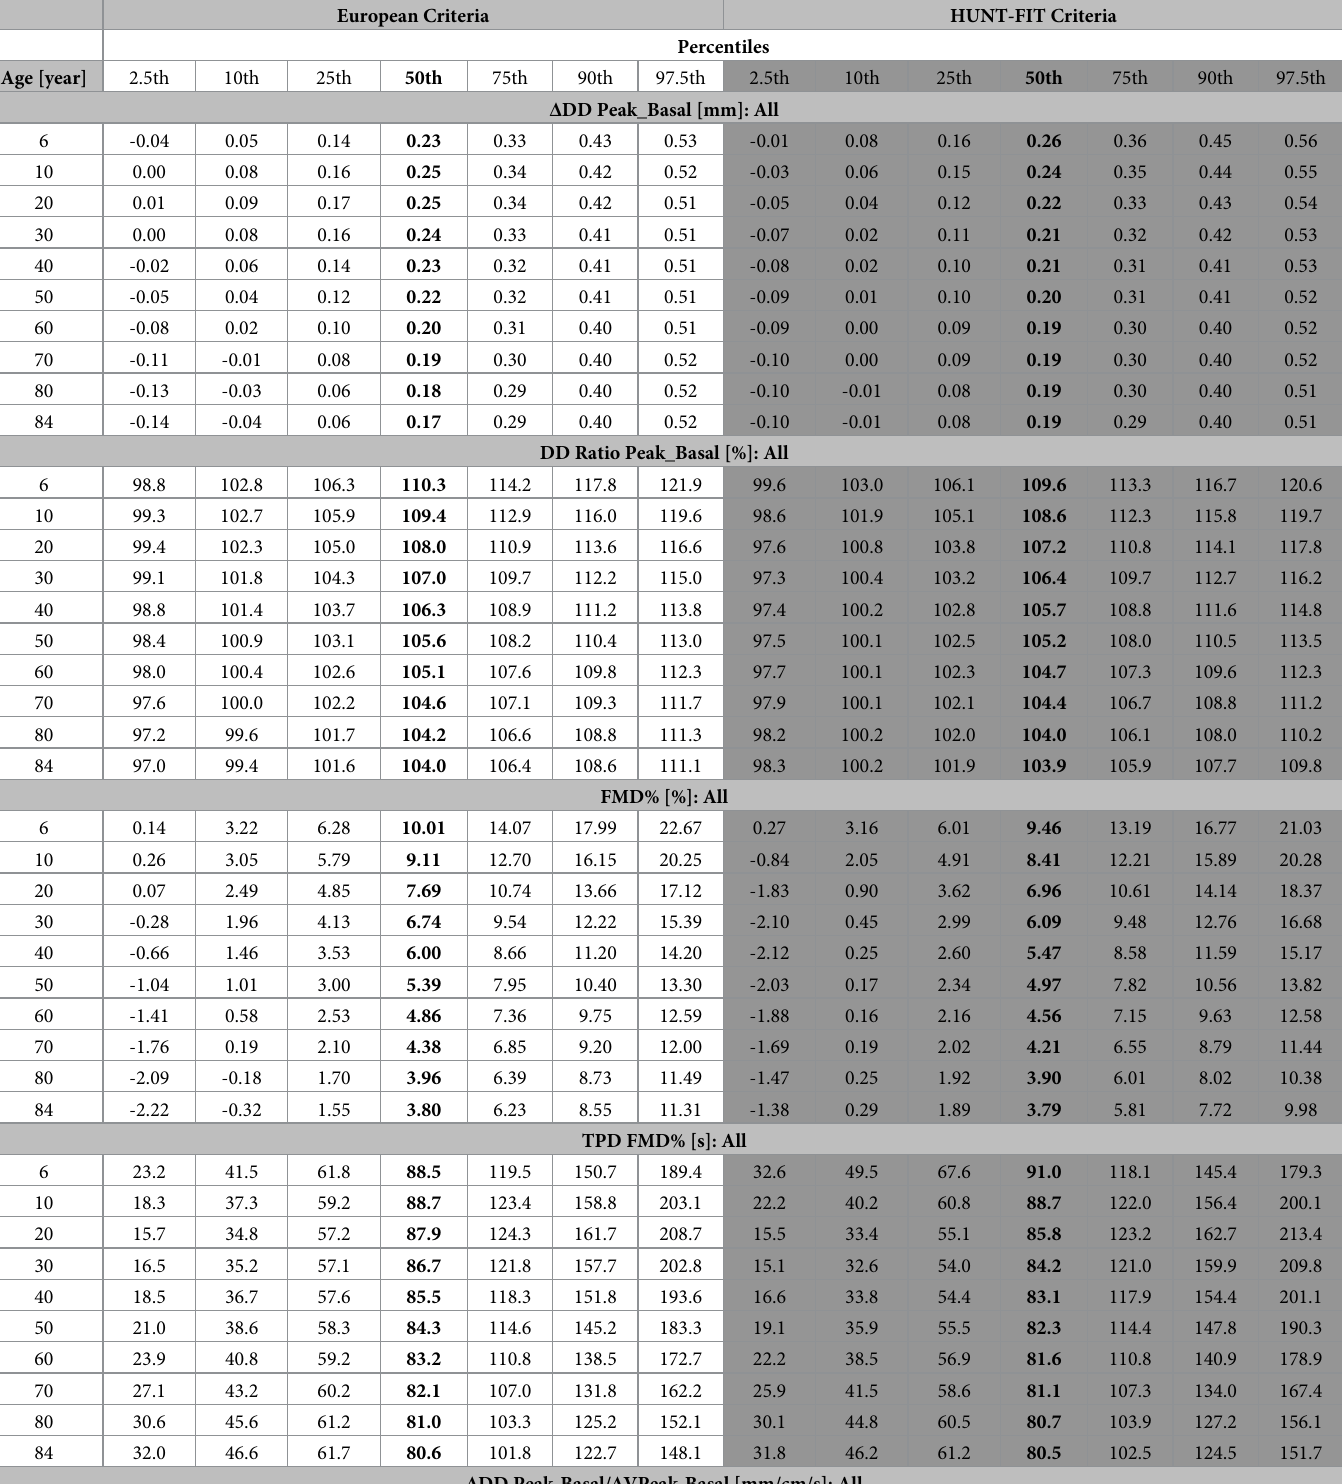
Table 6. Vascular reactivity indexes RIs (European and HUNT-FIT criteria; detailed by decade of life). European Criteria HUNT-FIT Criteria